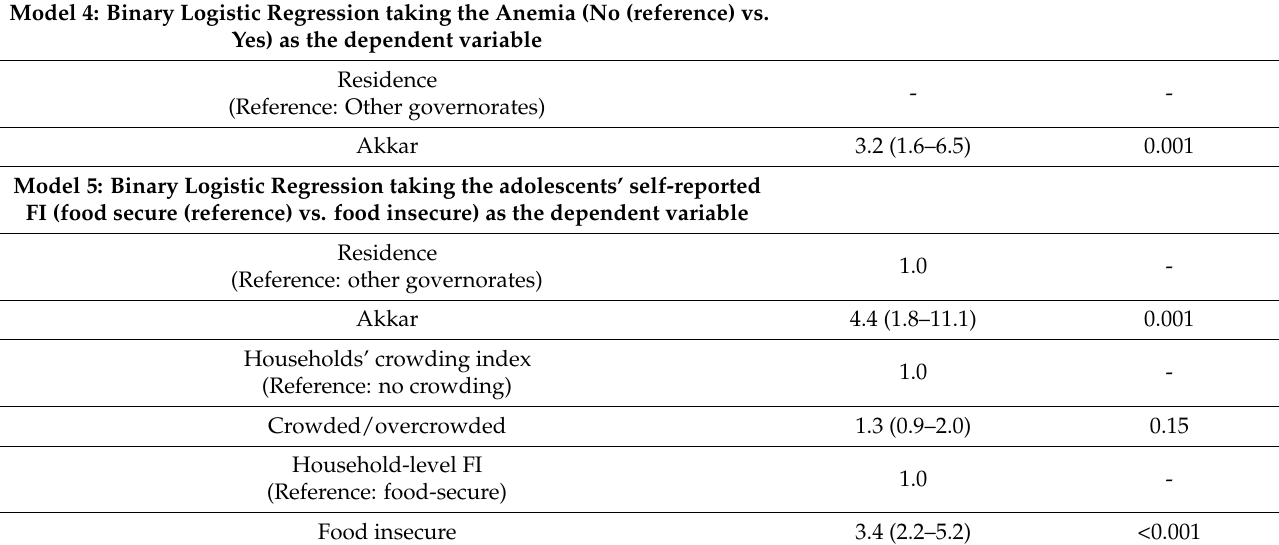
Table 3. Cont. Model 4: Binary Logistic Regression taking the Anemia (No (reference) vs.